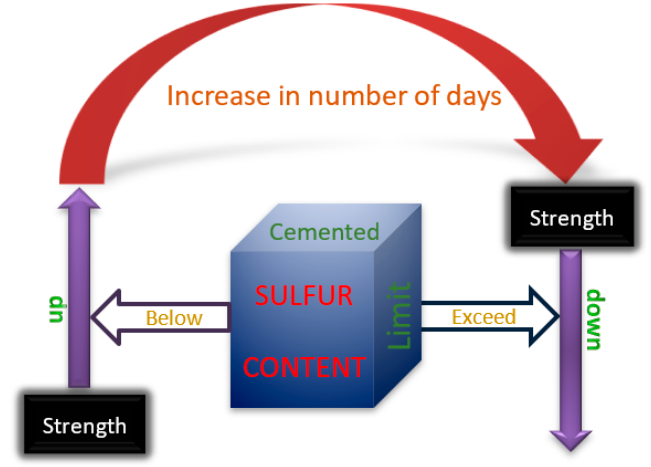
Figure 10. Relationship between critical value of sulfur content and age on strength of cemented tailings backfill.